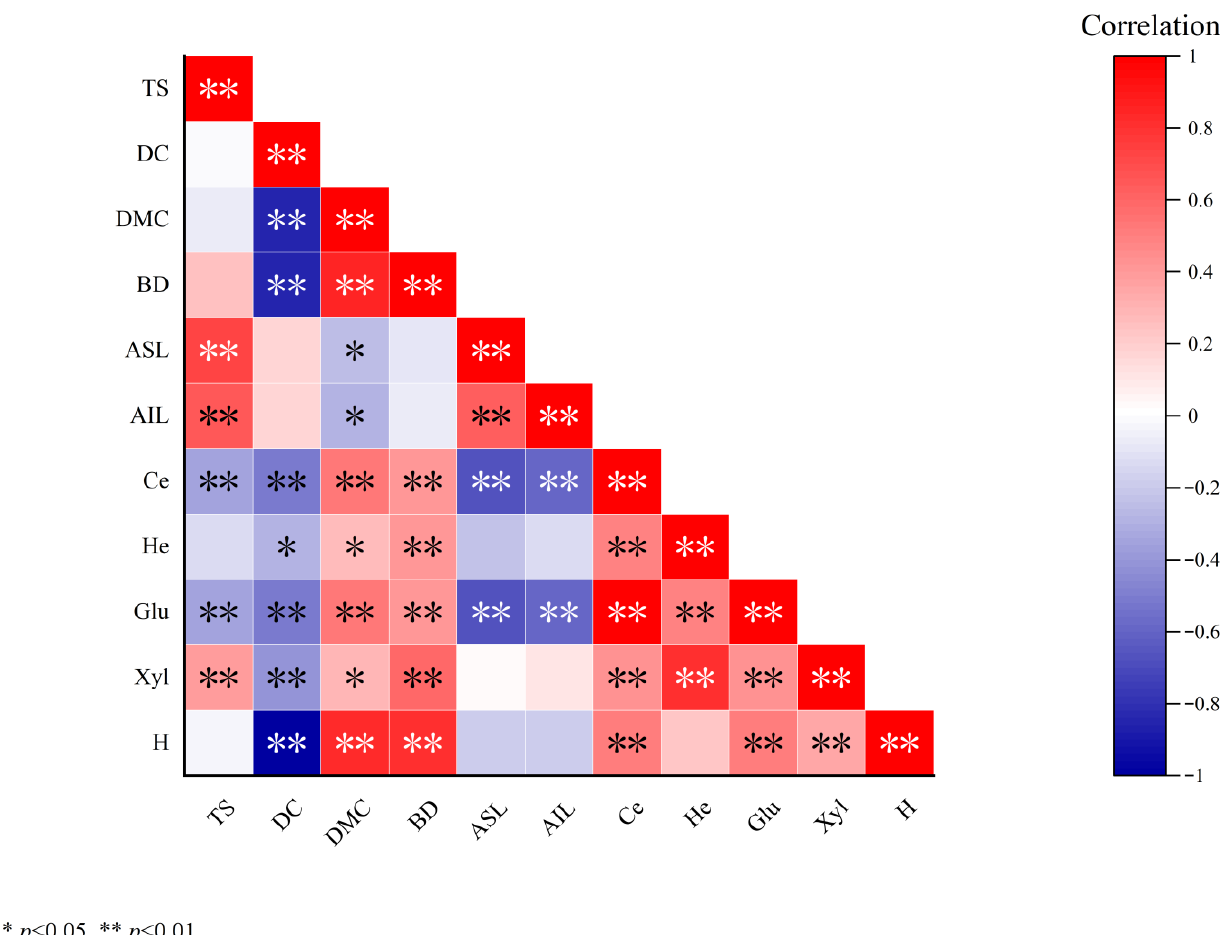
Figure 5. The correlation analysis between the various indicators between the decay classes and tree species. * p < 0.05; ** p < 0.01; TS, tree species; DC, decay class; BD, basic density; ASL, acid-soluble lignin; AIL, acid-insoluble lignin; Ce, cellulose; He, hemicellulose; Glu, glucose; Xyl, xylose; H, hardness. Red labels indicate positive correlations and blue labels indicate negative correlations.